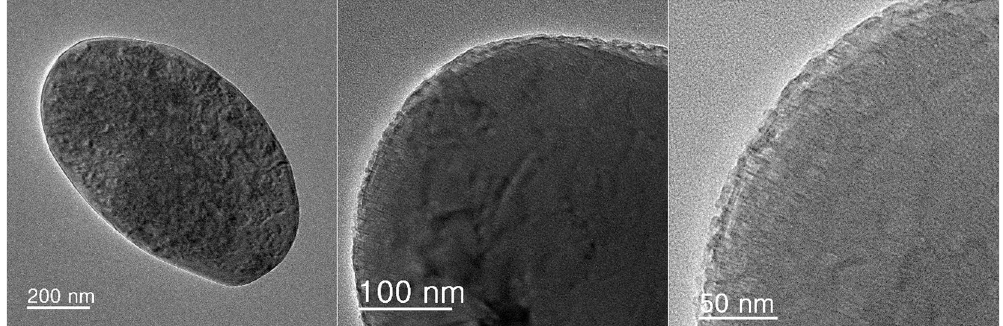
Figure 3. TEM images of